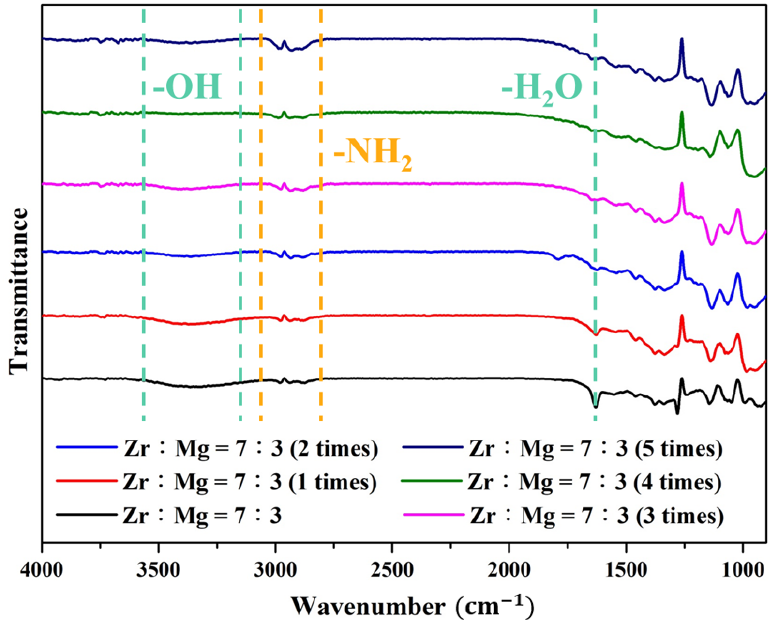
Figure 9. The FT-IR spectra of the APTMS-modified Zr–Mg mixed oxide aerogels with different times of APTMS modification.